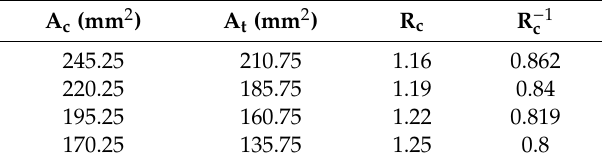
Table 1. Di ff erent intake contraction ratio at supersonic speed.